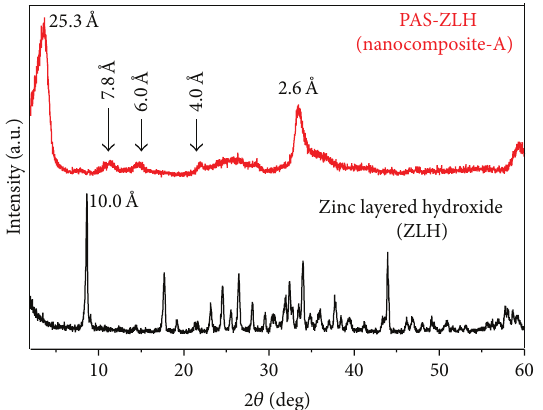
Figure 1: X-ray diffraction pattern of zinc layered hydroxide (ZLH) and PAS-ZLH (nanocomposite-A).